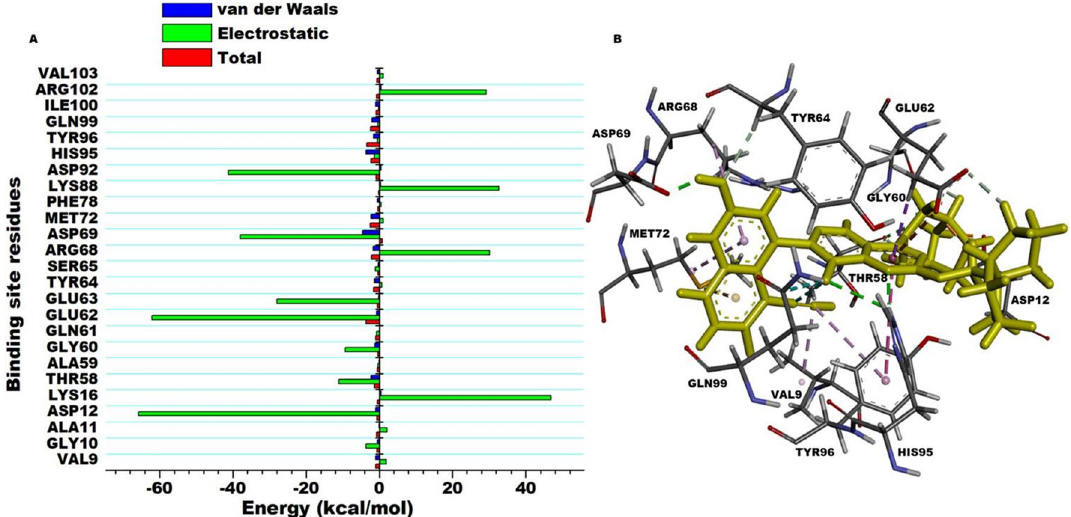
Figure 5. Per-residue decomposition analysis showing binding site residue energy contributions towards the complexing of MRTX1133. Electrostatic energy featured prominently towards the total free binding energy. ( A ) Shows the energy plots. ( B ) Shows the interacting